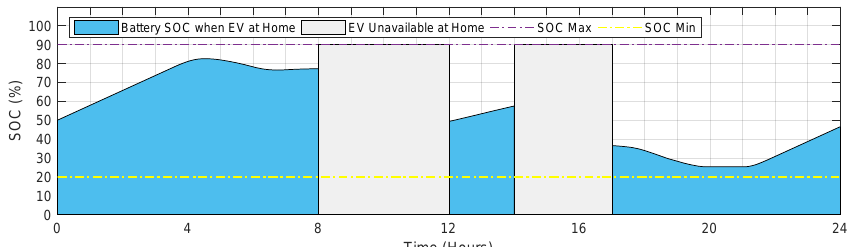
Figure 8. State of charge curve of EV when the proposed strategy is used to managing the energy in a smart home equipped with PV and EV.